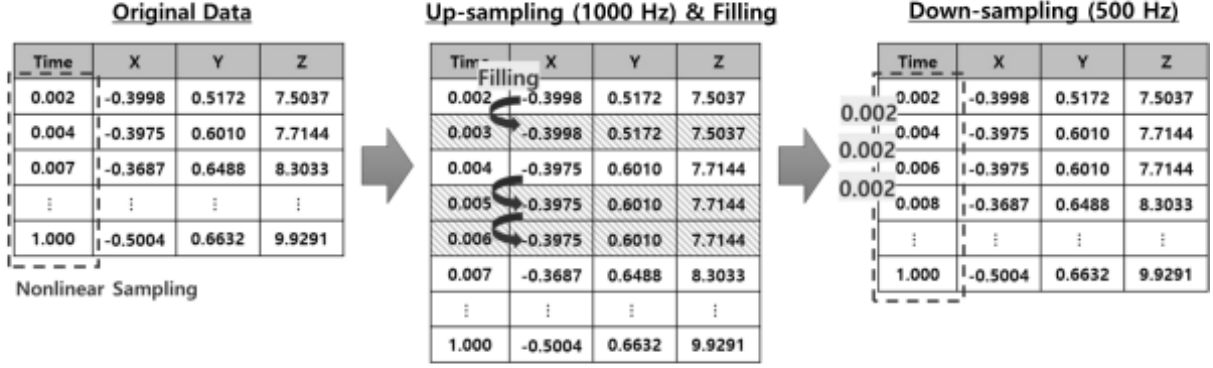
Figure 2. Processing for fixed